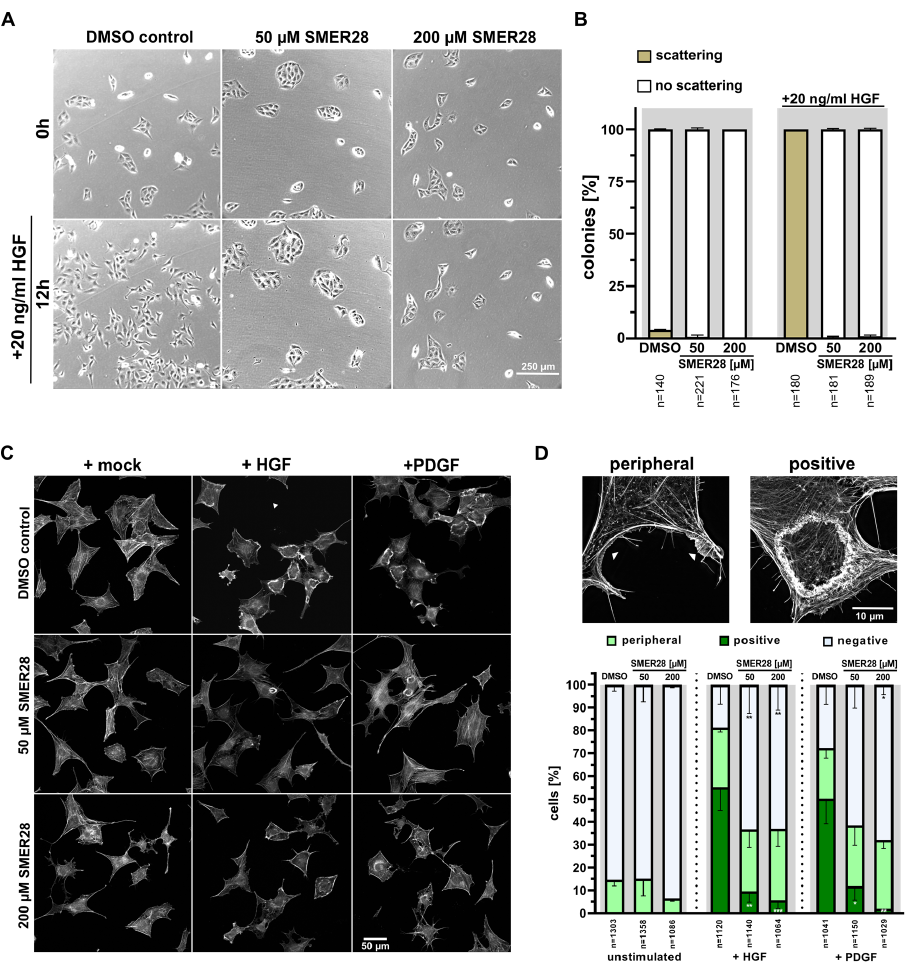
Figure 4. SMER28 inhibits growth factor-mediated cell scattering and membrane ruffling. ( A ) Colony- forming MDCK cells were stimulated with 20 ng/mL HGF in the presence or absence of 50 or 200 µ M SMER28, as indicated, and imaged every 15 min by phase contrast microscopy for 12 h. ( B ) Quantification of MDCK scatter assay. Colonies were categorized as “no scattering” versus “scattering” as described in Materials and Methods. Data were collected from three independent experiments and represent means ± s.e.m; n = total numbers of cells analyzed. ( C ) NIH/3T3 cells were serum-starved for 16 h in DMEM with treatments as indicated on the left. Cells were then treated with DMEM with or without HGF or PDGF for 5 min, as indicated, stained with phalloidin to visualize the F-actin cytoskeleton and imaged by spinning disk microscopy. ( D ) Quantification of growth factor responses according to examples shown above the graph. Images show maximum intensity projections of super-resolution SIM images. Cells were categorized as being non-responsive (negative) versus harboring peripheral ruffles (peripheral) or circular dorsal ruffles (positive). Data were collected from three independent experiments and represent means ± s.e.m; n=total number of cells analyzed. * p < 0.05, ** p < 0.01, *** p < 0.001, one way